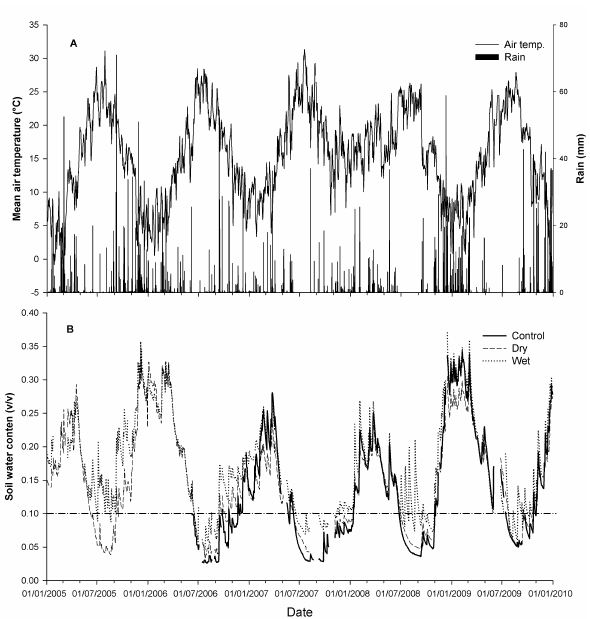
Fig. 1. Daily mean air temperature and precipitation events recorded by the meteorological station at the site from 2005 to 2010 (a) . Soil water content measured in the control, dry and wet plots, from 2005 to 2010 (b)